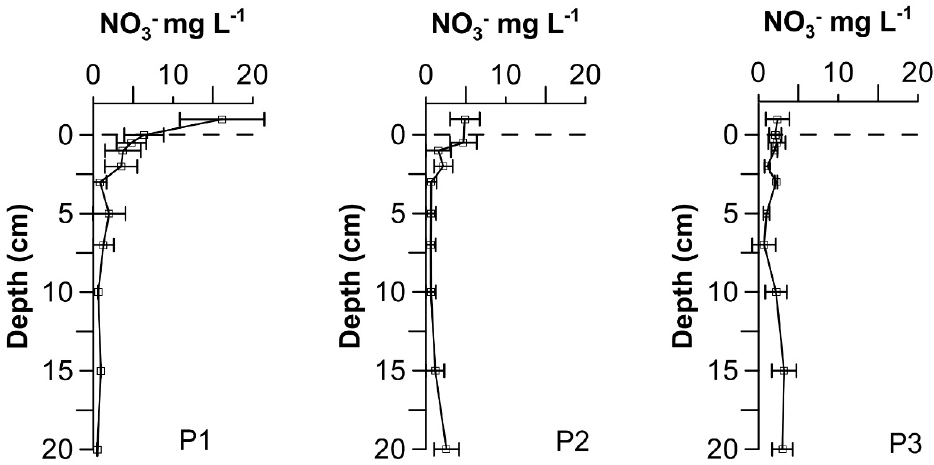
Figure 7. Average nitrate ‐ nitrogen pore water measurements in three pools along the main stream of the Chaminé River. P1, P2 and P3 are pore water ‐ sediment cores from each sampling